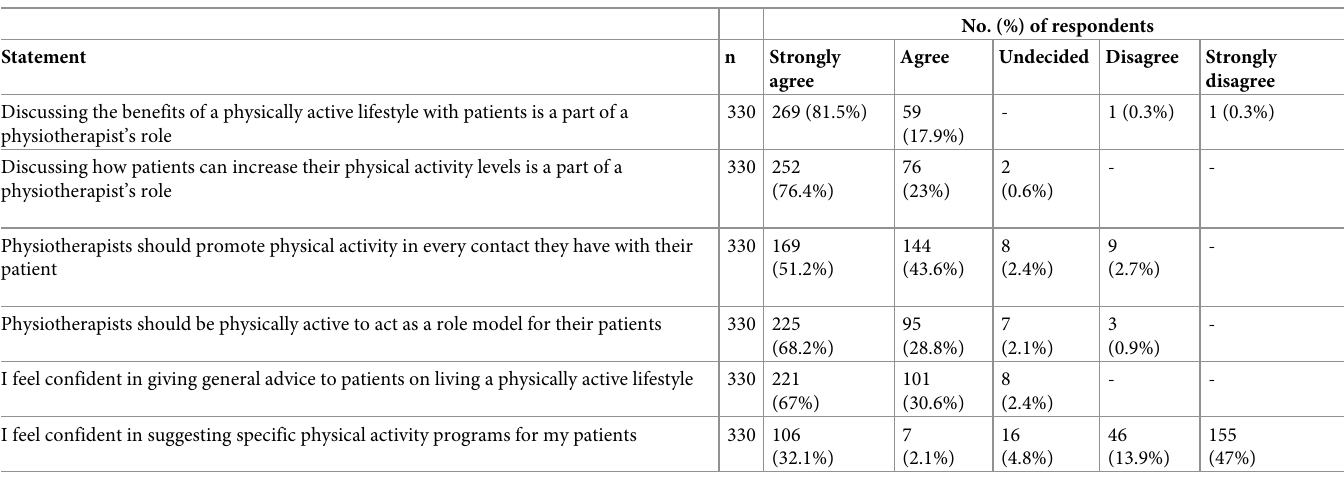
Table 2. Perception and confidence statements of respondents.